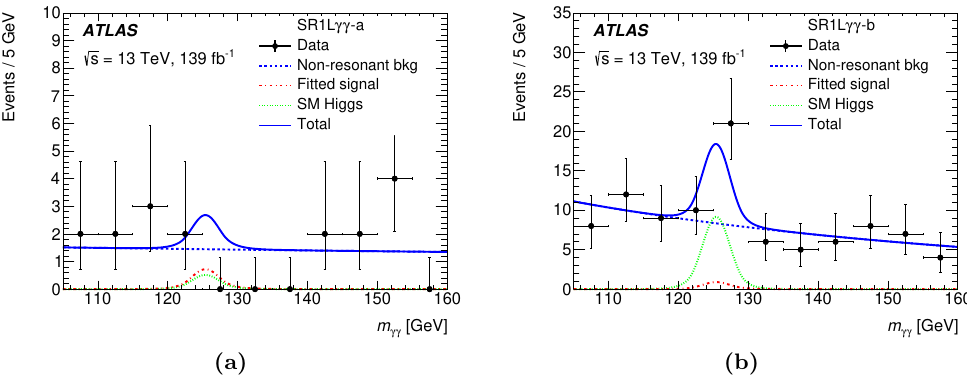
Figure 7 . Diphoton invariant mass spectra and the corresponding (cid:12)tted signal and background in the signal regions (a) ‘SR1L (cid:13)(cid:13) -a’ and (b) ‘SR1L (cid:13)(cid:13) -b’. The signal samples shown correspond to ! W (cid:6) ~ (cid:31) 0 the ~ (cid:31) (cid:6) ~ (cid:31) 0 h ~ (cid:31) 0 signal with m (~ (cid:31) (cid:6) = ~ (cid:31) 0 ) = 200 GeV and m (~ (cid:31) 0 ) = 0 : 5 GeV. The non-resonant 1 2 1 1 1 2 1 background (dashed curve), the SM Higgs boson (dotted curve), and the signal (dash-dotted curve) are obtained from a signal-plus-background (cid:12)t to the full m (cid:13)(cid:13) spectrum in ‘SR1L (cid:13)(cid:13) -a’ (a) and ‘SR1L (cid:13)(cid:13) -b’ (b) separately. The total of these contributions is shown by the solid curves.